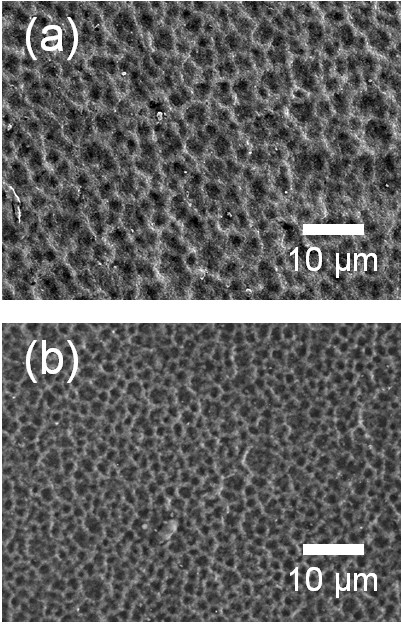
Surface SEM images of the (a) Al2O3-PMMA (15 vol.%) composite films and (b) Al2O3films.